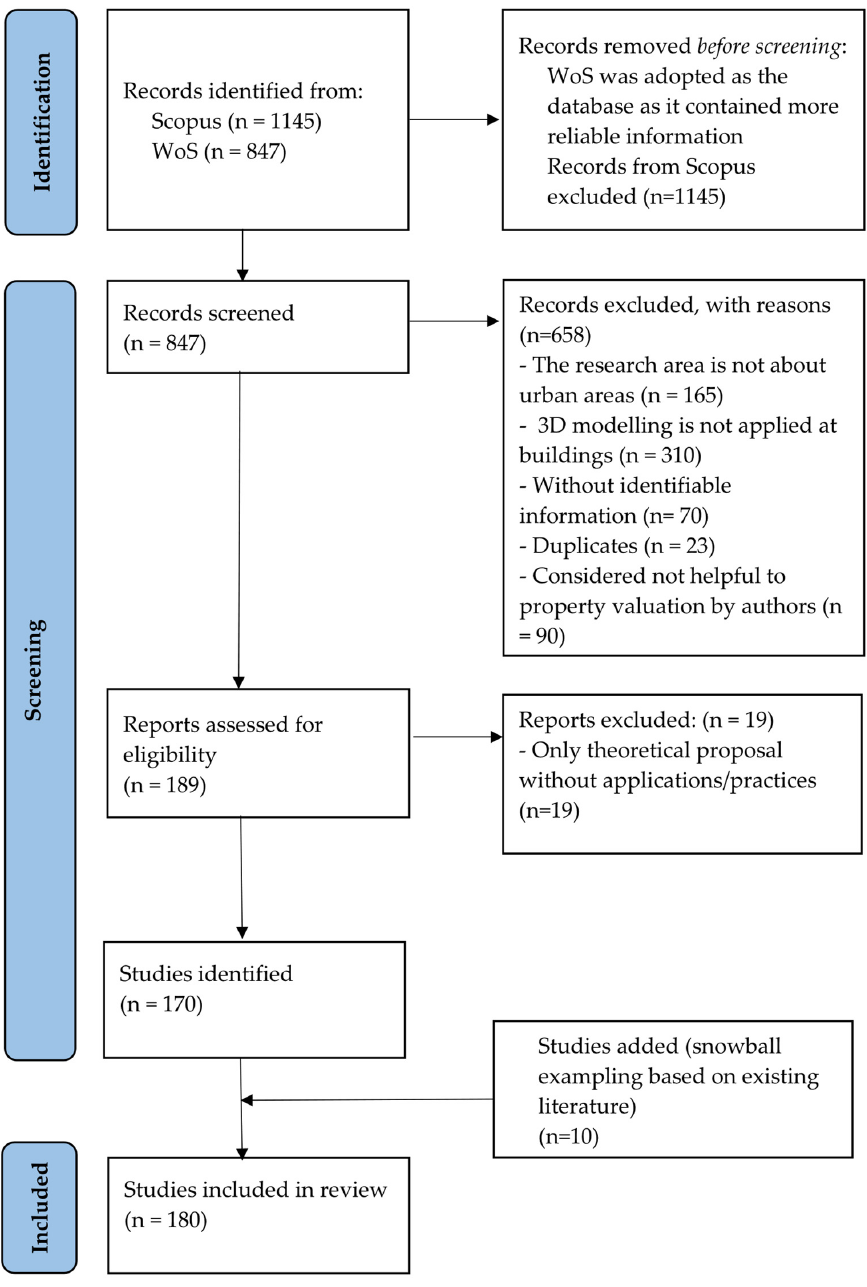
Figure 5. PRISMA 1 flow diagram of literature search.